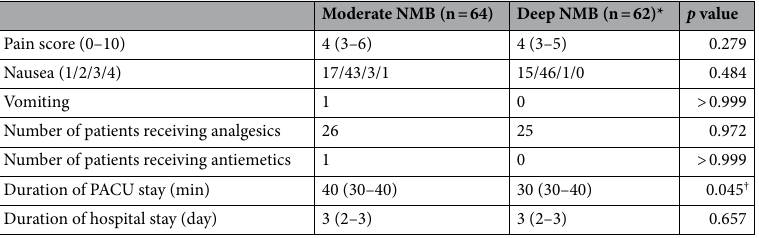
Table 4. Recovery data. Values are presented as the median (interquartile range) or number of subjects. NMB, neuromuscular block; PACU, post-anesthesia care unit. *2 patients transferred to intensive care unit in deep NMB group. † p value < 0.05 between-group